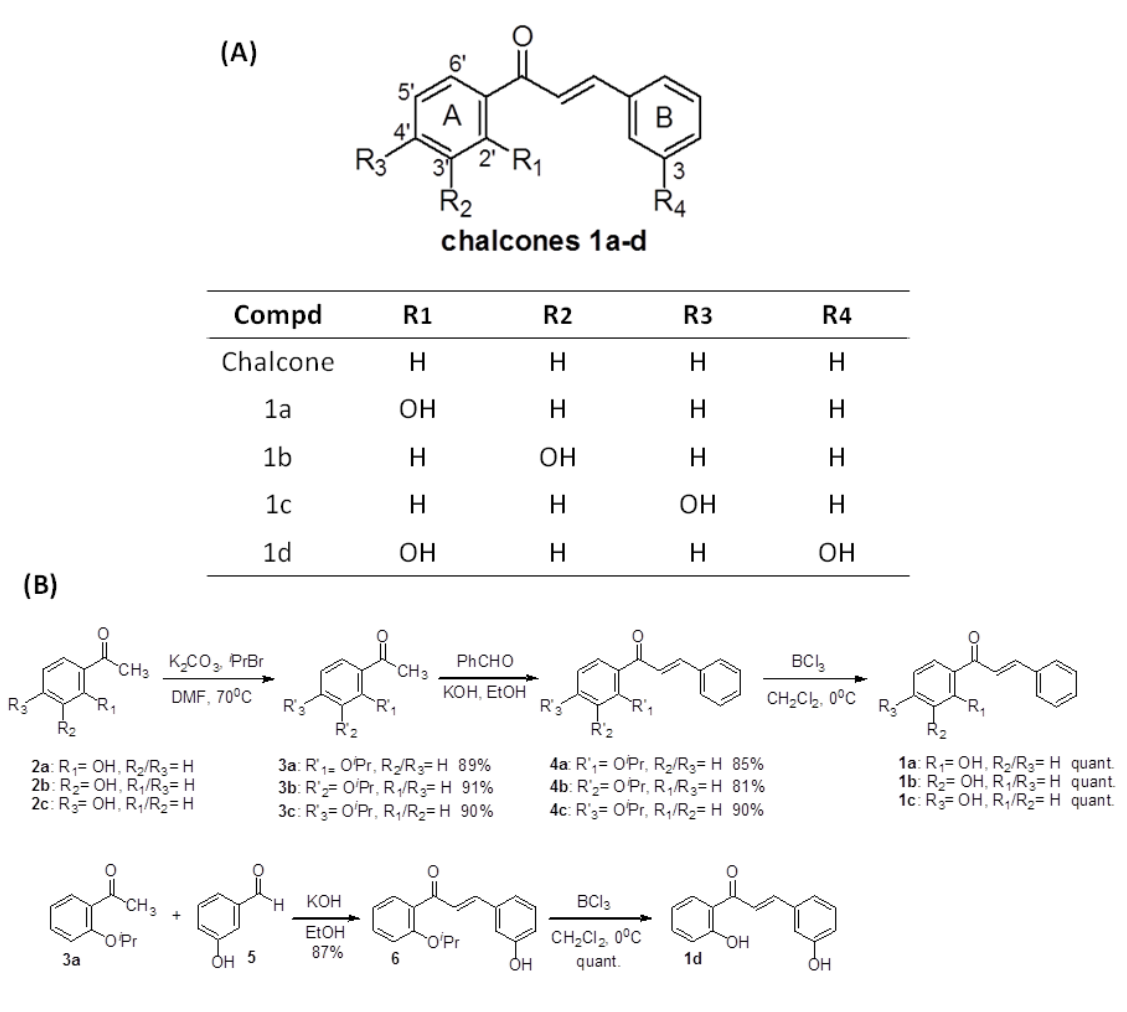
Figure 1. ( A ) Structures of chalcone and compounds 1a – d ; ( B ) Synthesis of compounds 1a – d